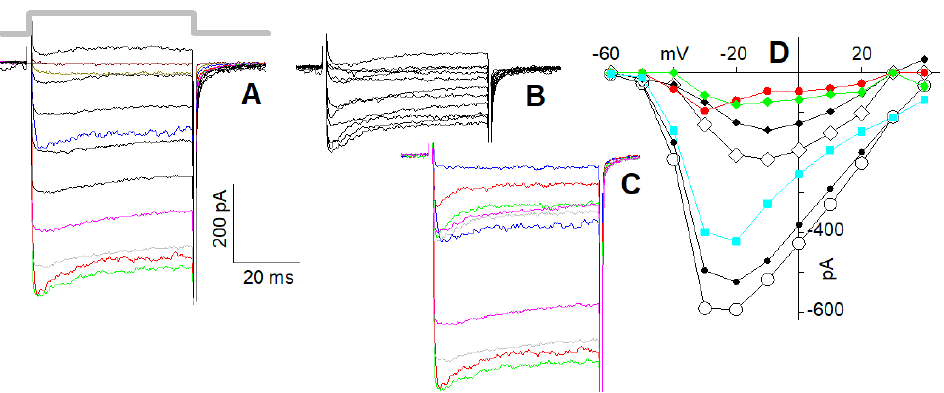
Figure 5. Effect of nifedipine on the L + R1 + R2 Ca 2+ current elicited by depolarisations in 4 mM Ca 2+ . ( A ) Ca 2+ currents evoked by the I–V protocol (whose timing is indicated by the thick grey line that applies to panel ( B , C ) as well) in a cell (recorded in perforated patch) displaying L, R1, and R2 components (inactivation time constant: 10.8 ms at − 30 mV); scales of ( A ) apply to ( B , C ) as well. ( B ) Effect of 10 µM nifedipine on the currents of the cell in ( A ). ( C ) Selected traces to the same depolar- isation in the control ( A ) and in nifedipine ( B ) (having smaller amplitude of ( A ) traces) are shown together to better compare them. ( D ) I – V relationships of the peak and plateau currents of ( A ) (open circles and filled circles, respectively, i.e., in the control), of the peak and plateau currents of ( B ) (open and filled diamonds, i.e., in nifedipine); plot of the differences between the open and the filled circles (red-filled circles), between the open and the filled diamonds (green-filled circles), and be- tween the filled circles and filled diamonds (turquoise-filled squares). Some current traces in ( A ) and all the traces of ( C ) are coloured with the same code of Figure 2 to better identify them; traces in ( B ) are not coloured because traces were too close. 2.5. I – Vs of L + R2 and of L + R1 + R2 Currents in 10 nM Ca 2+ In cells exhibiting the L and R2 components only (Figure 6A), the monovalent ion current recorded in 10 nM Ca 2+ (Figure 6B) was not simply reduced by nifedipine (Figure 6C) by a constant scaling factor as was found above in 4 mM Ca 2+ (Figure 4). Surprisingly, in nifedipine, the isolated R2 component decayed exponentially during the depolarising steps (Figure 6C; time constant: 6.7 ± 0.7 ms at − 50 mV; n = 8): nifedipine reduced the maximal cation current (at − 50 mV) by a factor of 2.93 ± 0.49, which became 4.57 ± 0.39 at the plateau (average current in 10 nM Ca 2+ : 457 ± 36 pA; average current in 10 nM Ca 2+ + 10 µM nifedipine: peak: 156 ± 14 pA, plateau: 100 ± 8.0 pA, n = 8). Moreover, the nifedipine cation current blockade was stronger at more negative potentials (Figure 6D,E). Figure 6. Effect of nifedipine on the L + R2 cation current in 10 nM Ca 2+ . ( A ) Ca 2+ current evoked by a − 20 mV depolarising step (whose timing is indicated by the thick grey line) in 4 mM Ca 2+ in a cell possessing the L and the R2 components. ( B ) Cation currents in 10 nM Ca 2+ elicited in the same cell